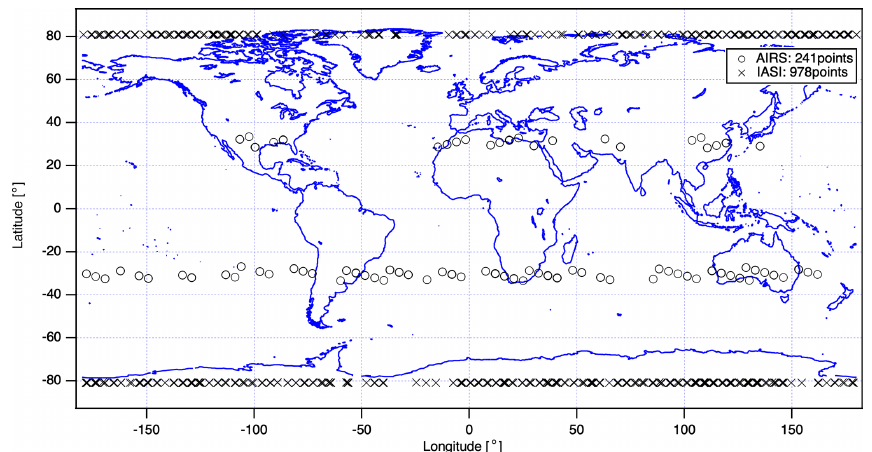
Figure 14. Inter-comparison between TANSO-FTS-2 and others: coincident latitude and longitude map between TANSO-FTS-2, AIRS (o), and IASI